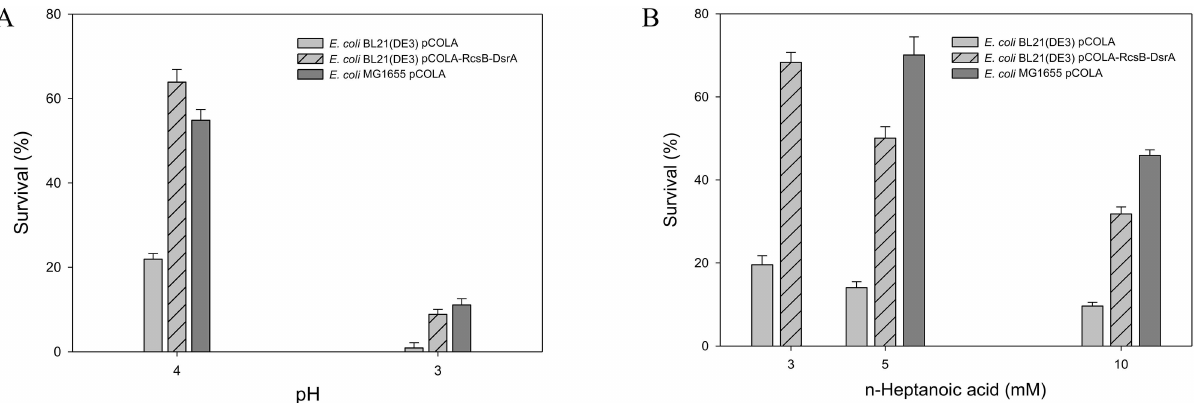
Fig 5. The survival frequency of the recombinant E . coli strains after 1 h exposure to acidified and n-heptanoic acid added culture medium. The survival frequencies of E . coli BL21(DE3) pCOLA (empty vector) ( grey bar ), E . coli BL21(DE3) pCOLA-RcsB-DsrA ( grey bar with diagonalline ) and E . coli K-12 MG1655 pCOLA ( dark grey bar ) were determinedunder different cultivation pH (A) and at different n-heptanoic acid concentration (B) as describedpreviously [34]. Values are the mean of more than three independent samples. Bars represent the standard error of the